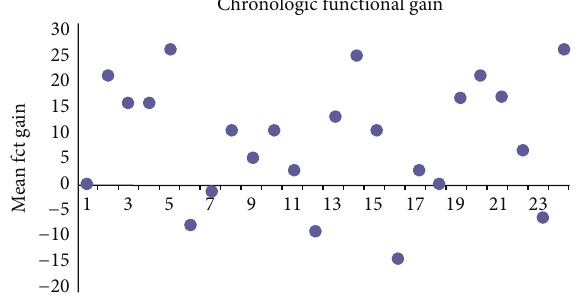
Figure 9: Mean functional gain (overclosure) in